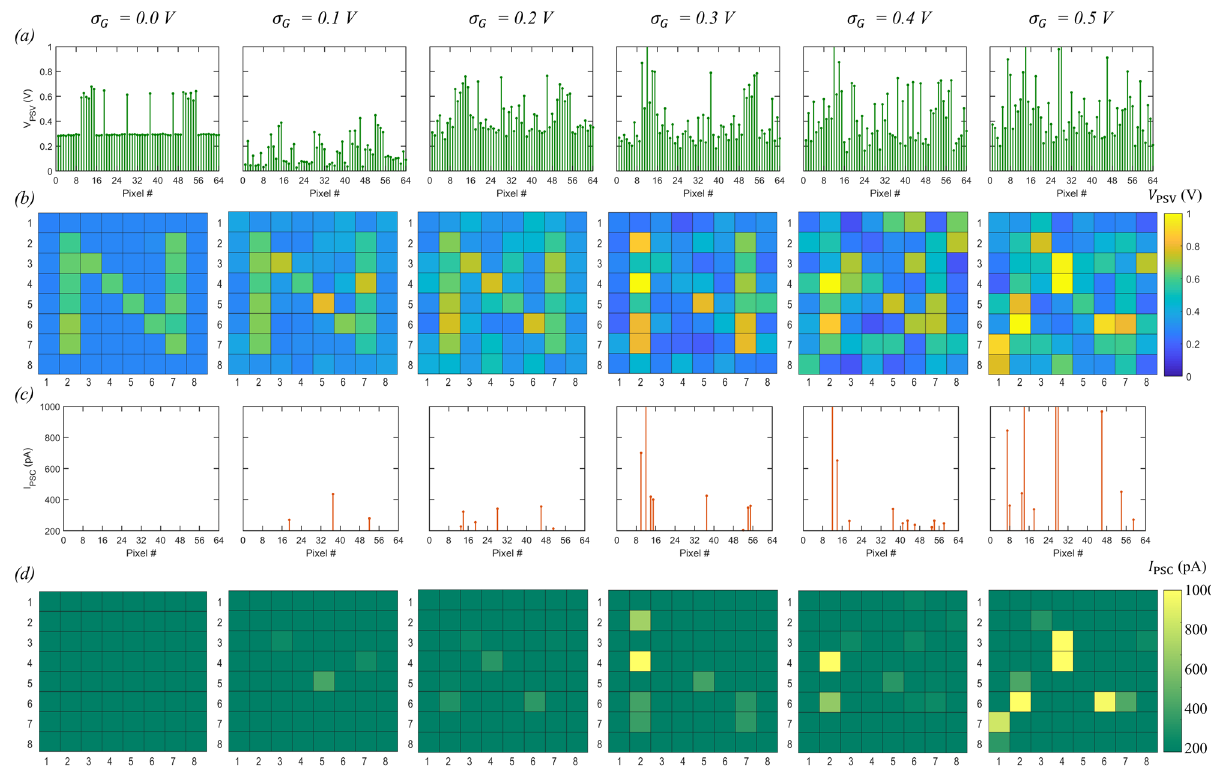
Fig. 3 Encryption process. a Pre-synaptic voltage, V PSV . b Colormaps of V PSV . c Post-synaptic current, I PSC . d Colormaps of I PSC for different values of noise standard deviation, σ G , when an 8 × 8 pixelated image of the letter ‘ N ’ is sensed and transduced using the corresponding T PT , T WGNA , and T SN